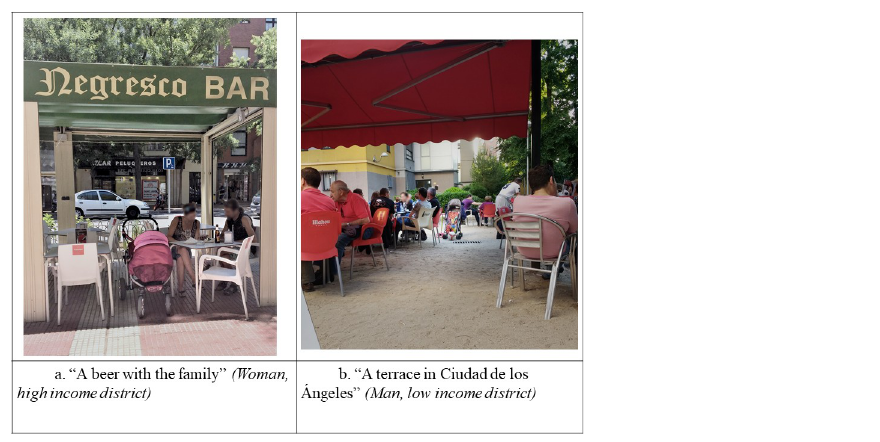
Fig 3. Photographs on children’s exposure to